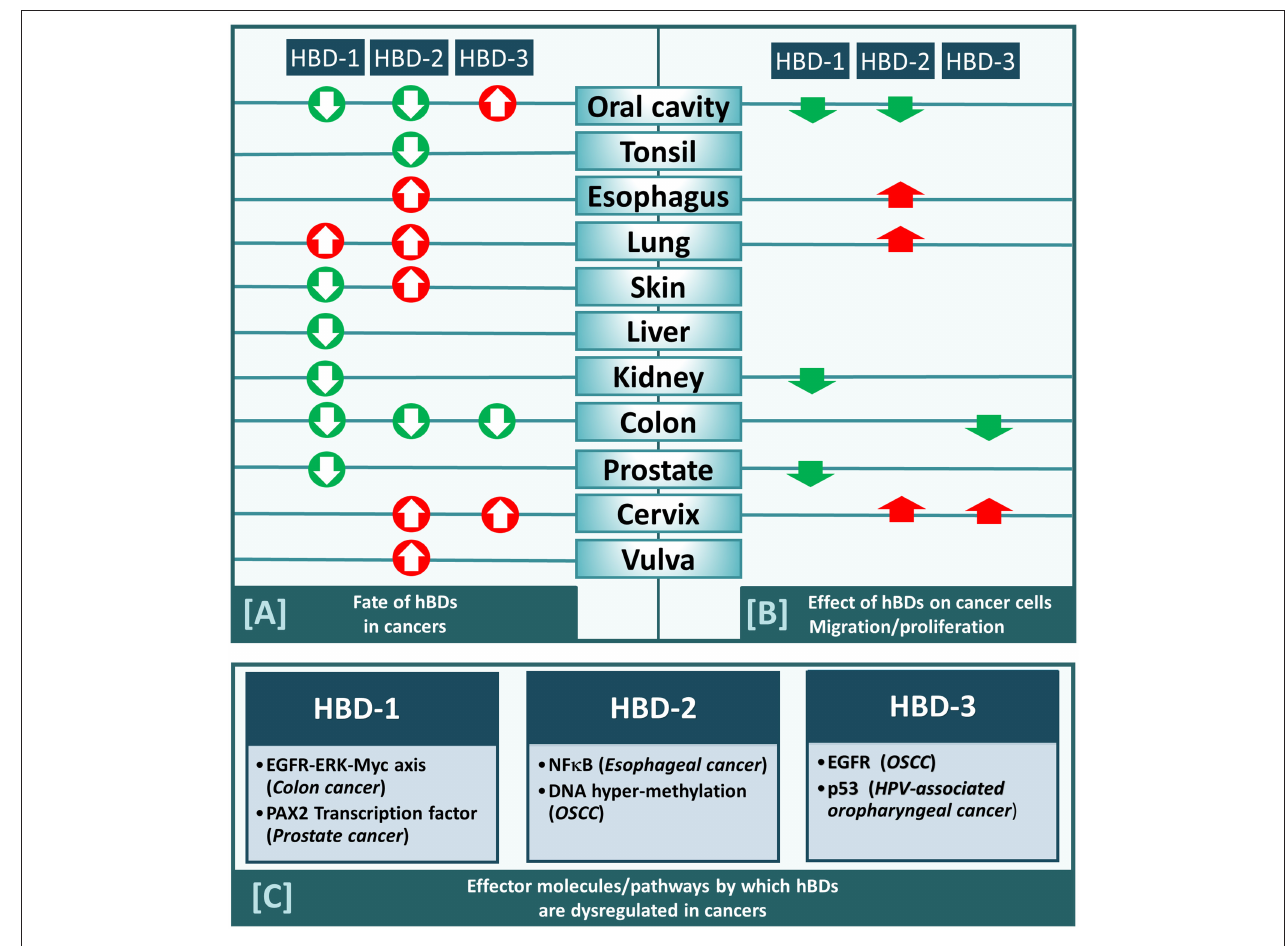
FIGURE 1 | (A) HBD-1,-2, and − 3 either increased (red arrow) or decreased (green arrow) in cancers from different anatomical locations within human body (as indicated). (B) HBD-1,-2, and − 3 either promote (red arrow) or inhibit (green arrow) migration/proliferation of cancers cells derived from different anatomical locations (as indicated). (C) Effector molecules/pathways by which each of the three defensins (hBD-1, − 2, and − 3) are dysregulated in